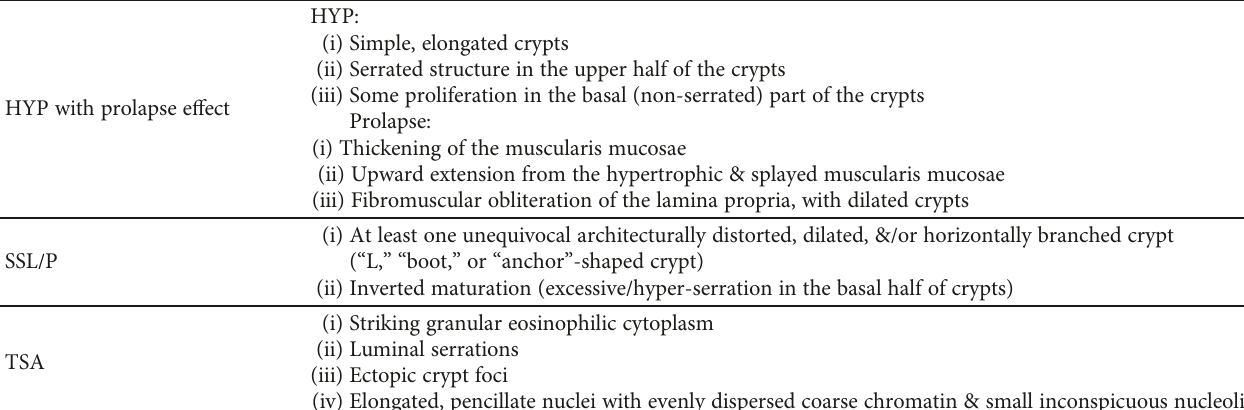
Table 6: Histological features of hyperplastic polyps with prolapse, sessile serrated lesions/polyps, and traditional serrated adenomas [1, 11, 18].